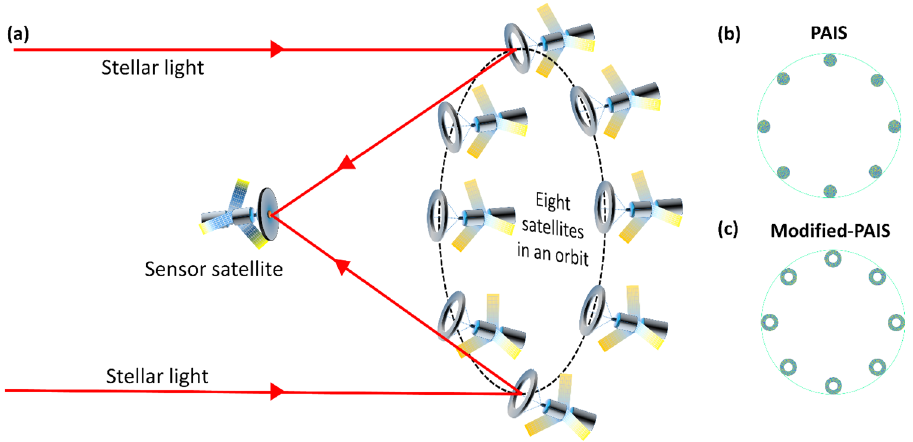
Figure 1. ( a ) A scheme of implementing M-PAIS for a possible future space telescope, ( b ) and ( c ) CPMs of PAIS and M-PAIS,